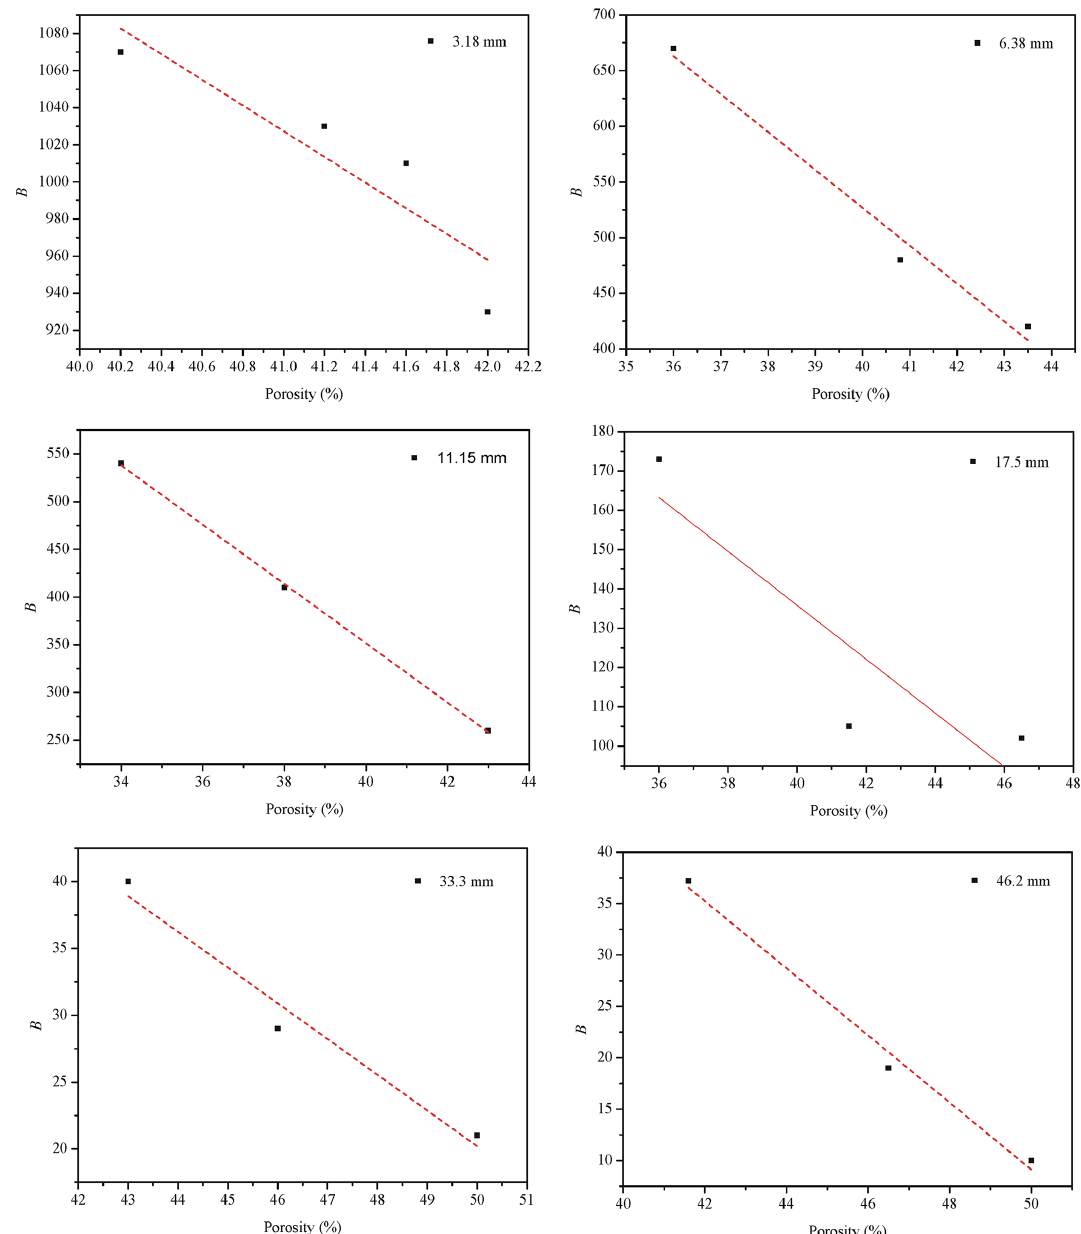
Figure 17. Variation of B with n for six gravels with different particle sizes.